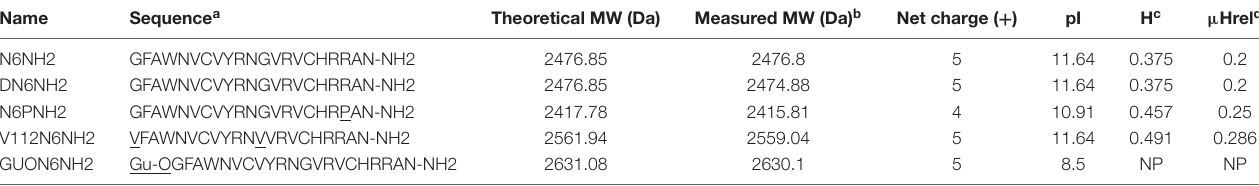
TABLE 1 | Peptide design and their key physicochemical